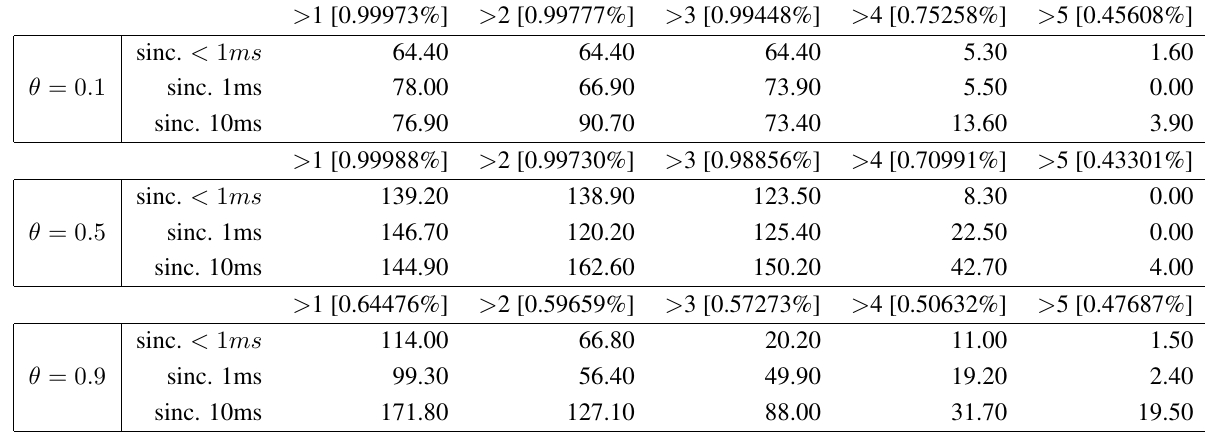
Table 2. Gunshot average location error